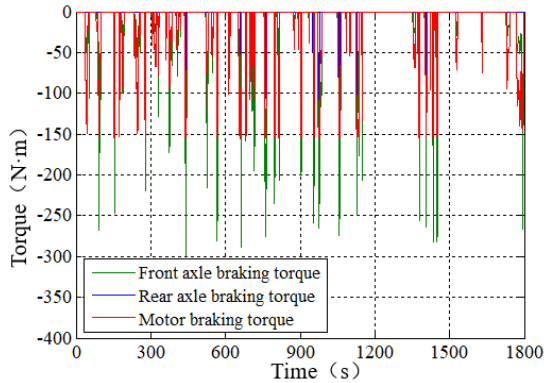
Figure 16. Vehicle braking torque distribution in the WLTC condition.